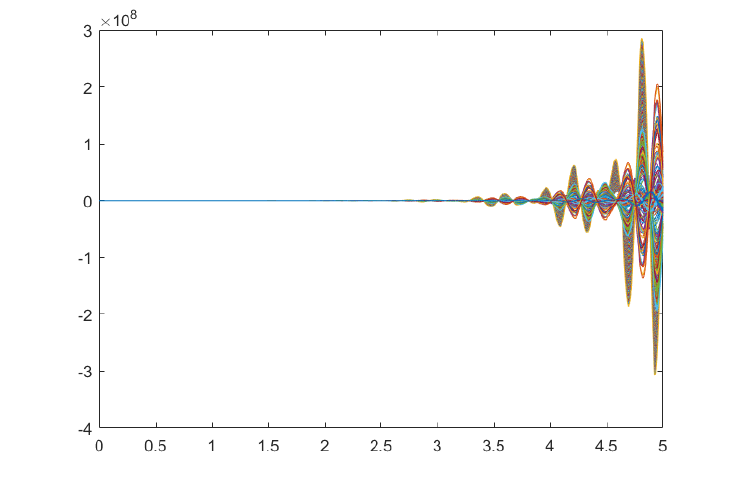
Figure 2. The state trajectories of open-loop systems with initial conditions ( − 2, 2).